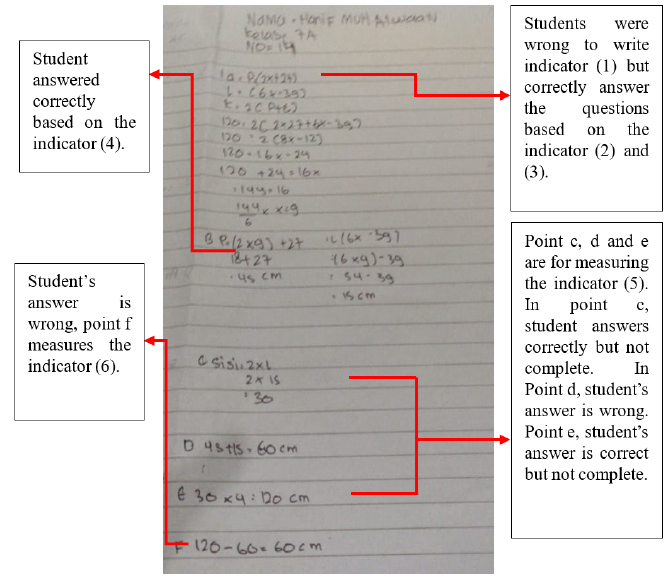
Fig. 3. Student’s answer sheet in the experimental